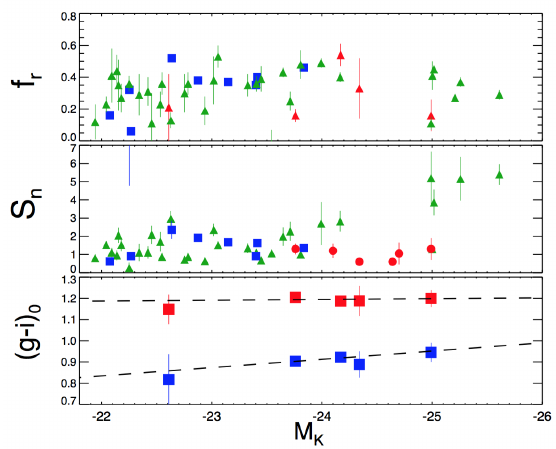
Figure 1. Upper panel : Globular cluster (GC) red fraction as function of 2MASS K -band luminosity, as a proxy for stellar mass. Red symbols represent our sample, while blue squares are taken from the [12] sample of 10 “low-density” early-type galaxies. Green triangles are the results from the ACS Virgo ClusterSurvey [1]; Middle panel : GC specific frequency. Same symbols, including the isolated ellipticals N7507 [7], N3585 and N5812 [8]; Lower panel : position of the red and blue peaks as a function of K luminosity for the five isolated ellipticals in